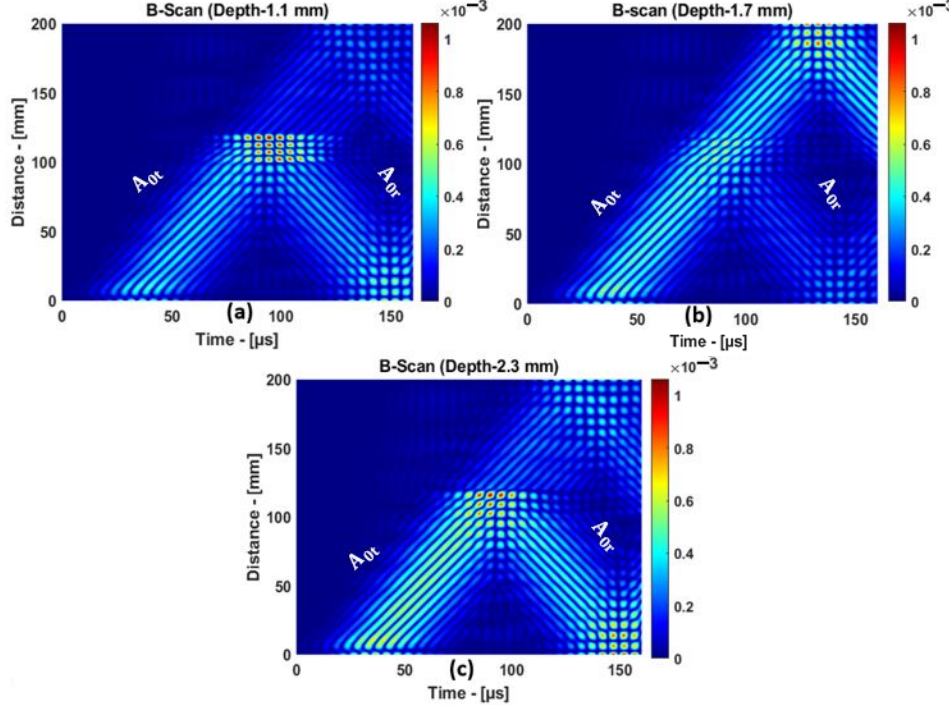
Figure 11. The A (cid:2868) mode reflection and transmission: delamination at ( a ) 1.1, ( b ) 1.7, and ( c ) 2.3